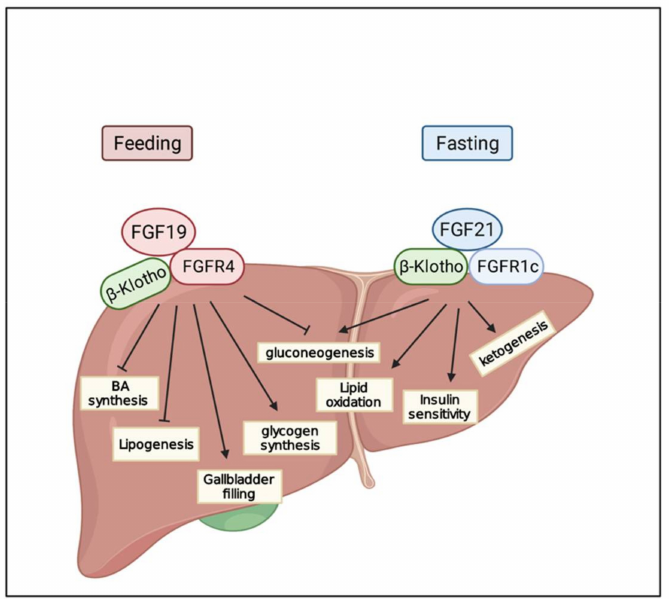
Figure 2. The regulation of FGF19 and FGF21 on liver metabolism. FGF19 is a feeding-response hormone and stimulated followed by increasing bile acid and FXR activation. In turn, FGF19 suppresses the expression of CYP7A1 to inhibit bile acid synthesis. Other than that, FGF19 exerts metabolism roles like insulin, such as stimulating glycogen and protein synthesis and inhibiting gluconeogenesis. FGF19 mainly binds to FGFR4 and β -klotho in the liver. On the contrary, FGF21 is a fasting-induced hepatokine and is partly comparable to glucagon, inducing a transformation to catabolic metabolism through binding to β